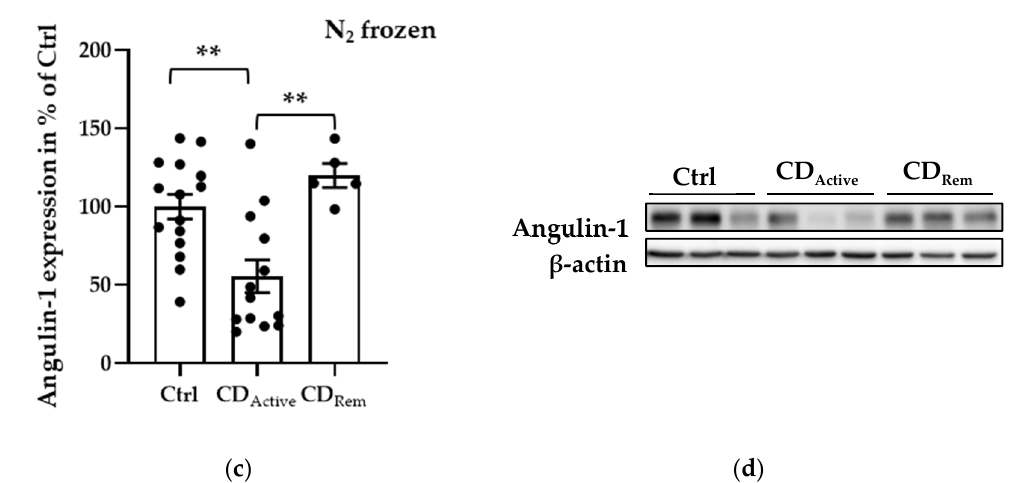
Figure 2. Angulin-1 protein expression analysis of human intestinal tissues. ( a ) Scatterplot with bar of angulin-1 in formalin-fixed paraffin-embedded (FFPE) section of Ctrl and CD. Mean value of Ctrl is set to 100%. Angulin-1 is downregulated in CD (Ctrl: 100 ± 19.42%, n = 6; CD: 55.82 ± 3.67%, n = 6, * p < 0.05). ( b ) Representative Western blots of intestinal tissues of Ctrl and CD. ( c ) Scatterplot with bar of angulin-1 in biopsies directly frozen after colonoscopy from Ctrl, active CD, and remission CD. Mean value of Ctrl is set to 100%. Angulin-1 is downregulated in active CD (CD Active : 55.59 ± 10.50%, n = 13) compared with Ctrl (Ctrl: 100 ± 7.95%, n = 15, ** p < 0.01) and remission CD (CD Rem : 120.00 ± 7.54%, n = 5, ** p < 0.01). ( d ) Representative Western blots of intestinal tissues of Ctrl and CD.